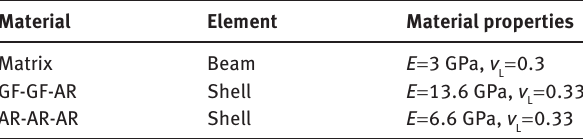
Table 7 Material properties of the quasi 3D model.